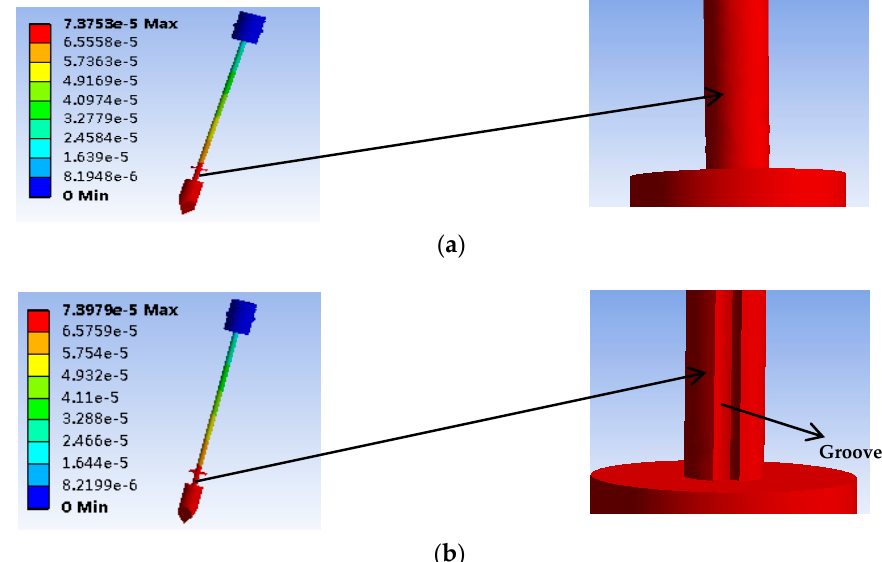
Figure 6. Simulation result: ( a ) Traditional puncture needle cylinder; ( b ) New type of puncture